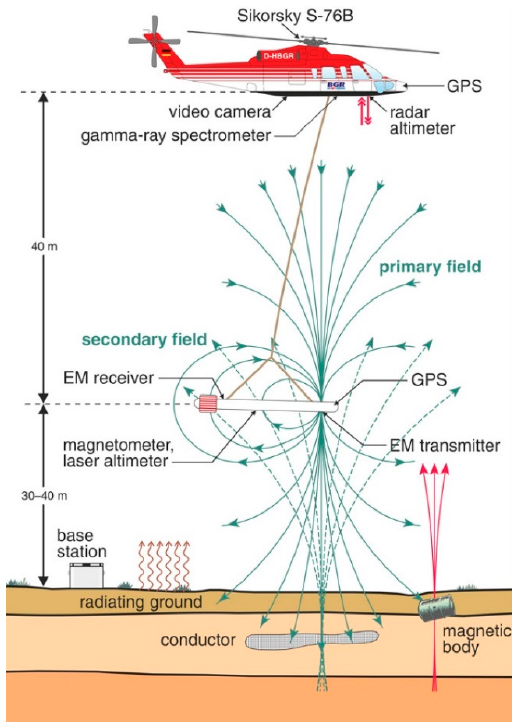
Figure 5. Sketch of BGR’s helicopter-borne geophysical system (after [29]).